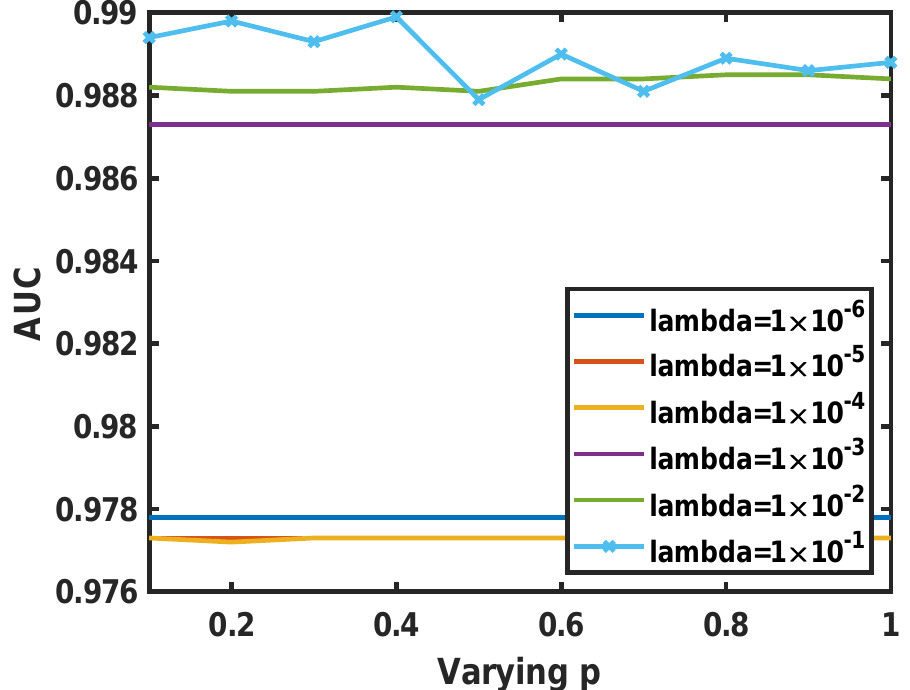
Figure 11. AUC values of different varying p , as well as lambda ( λ ), in the San Diego